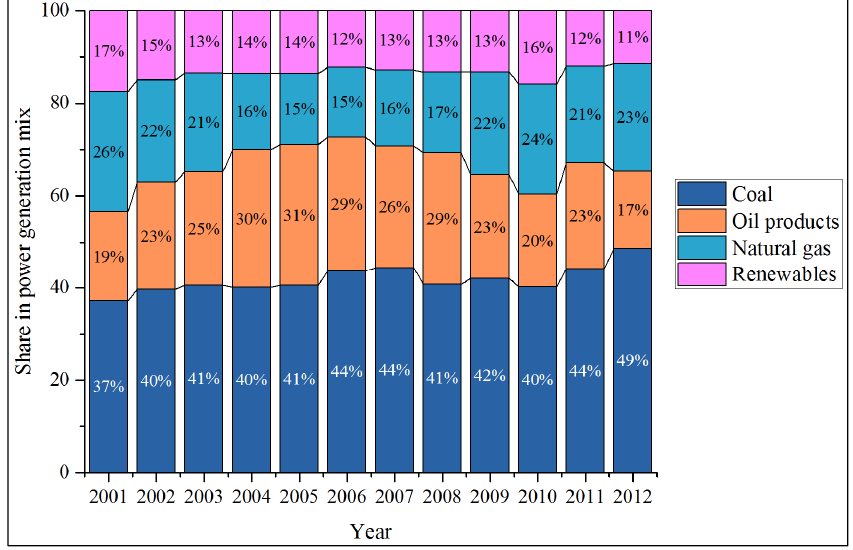
Figure 13. Indonesia: power generation mix.